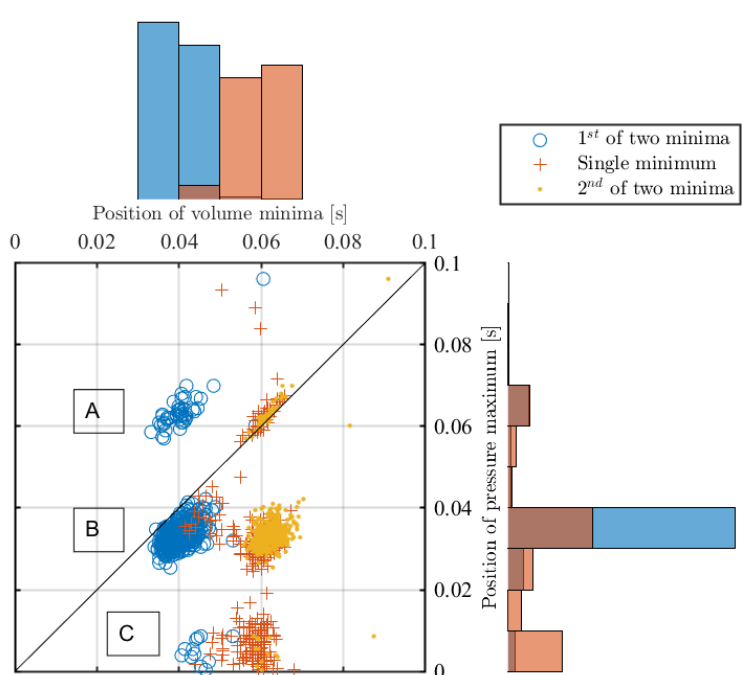
Figure 3. Position of the pressure maximum in relation to the position of the volume minima for all passages at 96.5 rpm. The passages are distinguished by the number of volume minima (1 or 2—upper histogram) and by the position of the pressure maximum (groups A, B, and C—right-hand histogram). The colour code of the histograms refers to the marker colour of the centre